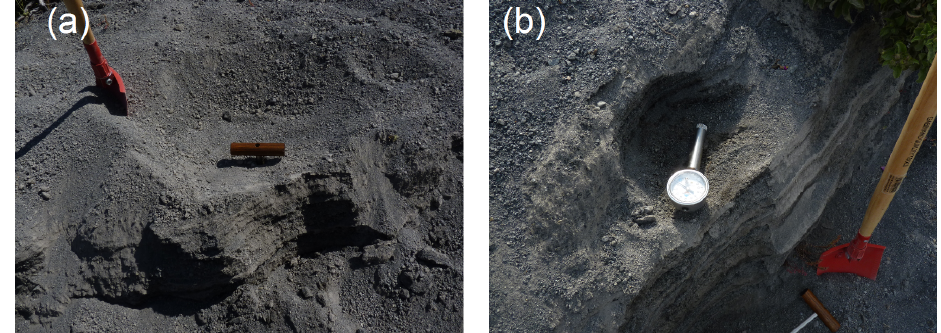
Figure A2. (a) Coring tool into the deposit before soil suction measurement. (b) Soil suction measurement on the 1888–1890 primary tephra fallout deposit on the NW volcano flank.